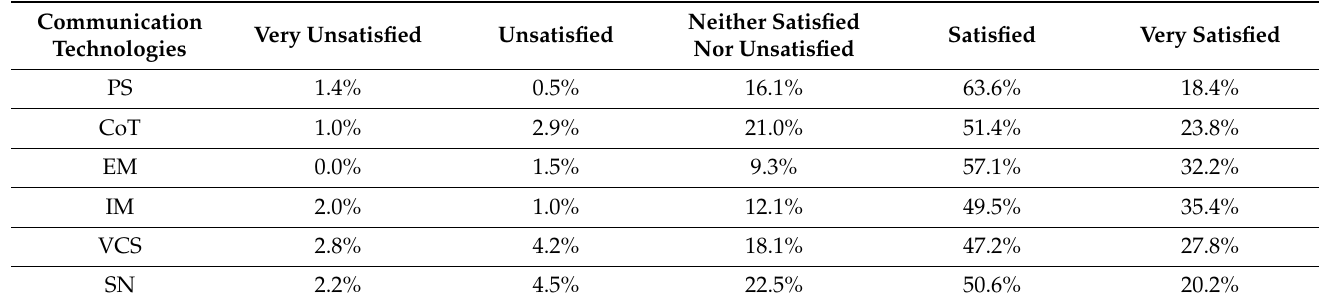
Table 25. Satisfaction on the use of communication technologies by students.